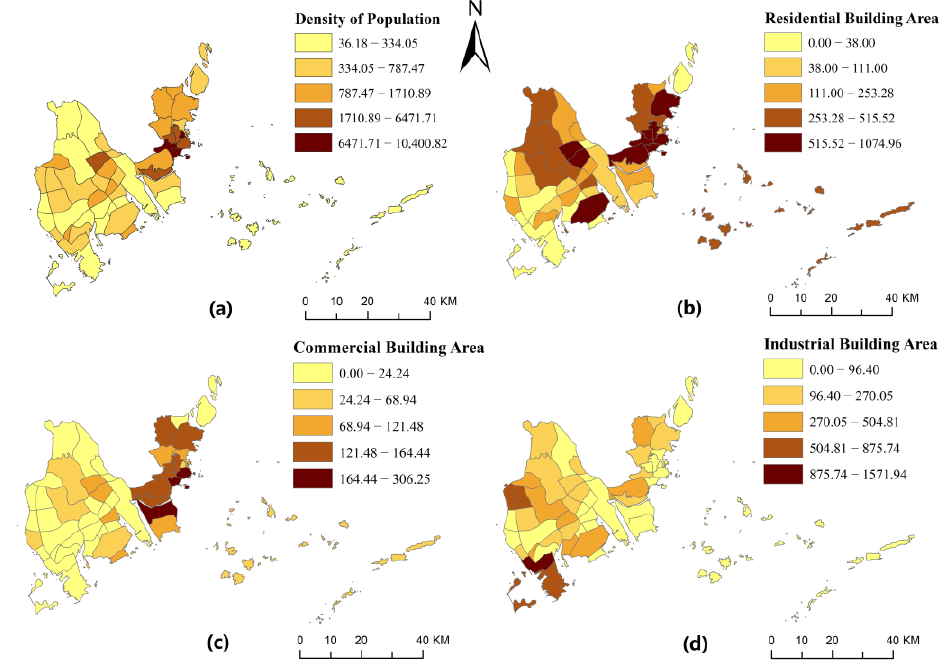
Figure 4. The spatial distribution of social spatial form index in Zhuhai: ( a ) density of population, ( b ) residential building area, ( c ) commercial building area, ( d ) industrial building area.